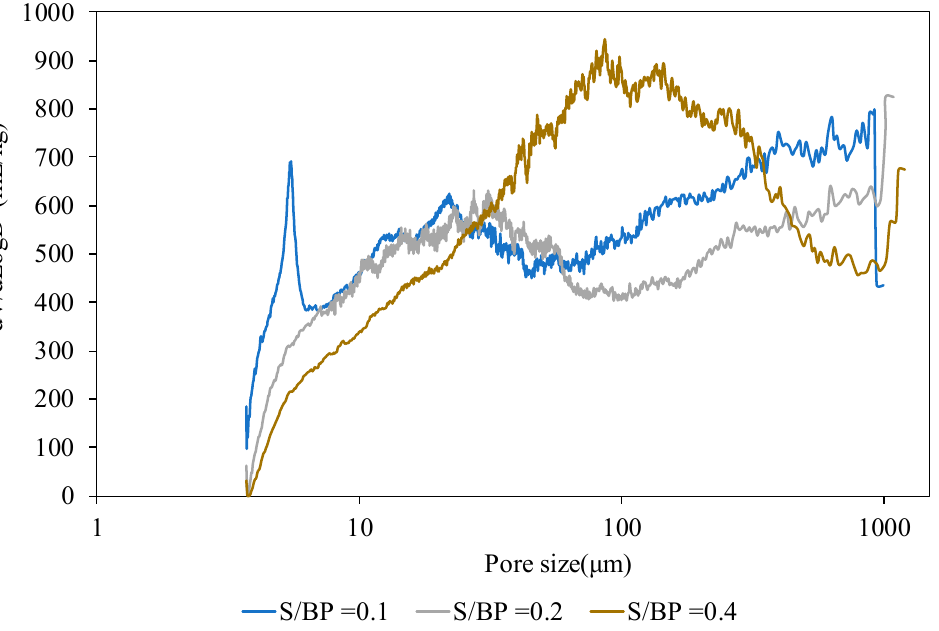
Figure 11. Pore size distribution in S ‐ BP composites with different S/BP ratios.